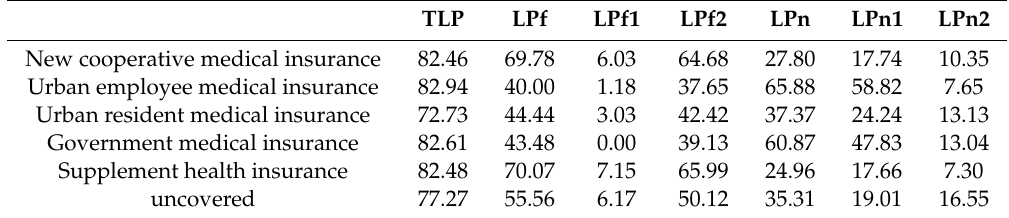
Table 4. Di ff erent types of health insurance coverage and labor participation rate (%).